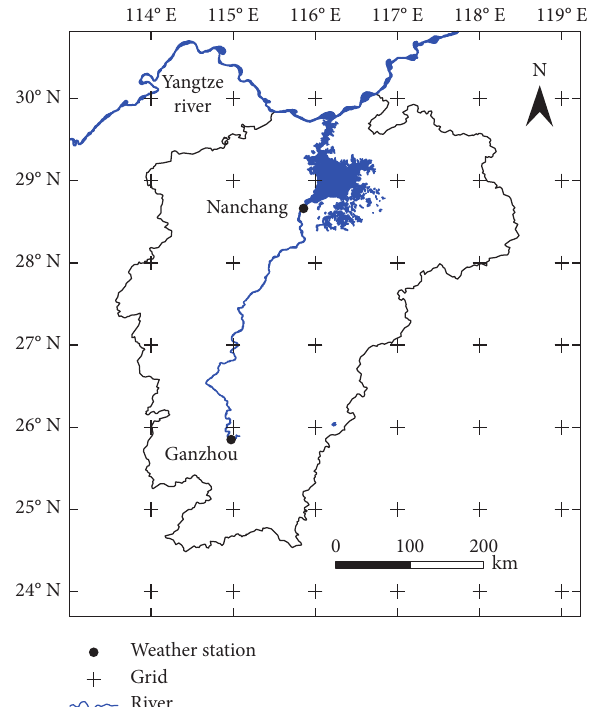
Figure 1: Location of the Nanchang and Guangzhou National Weather stations,